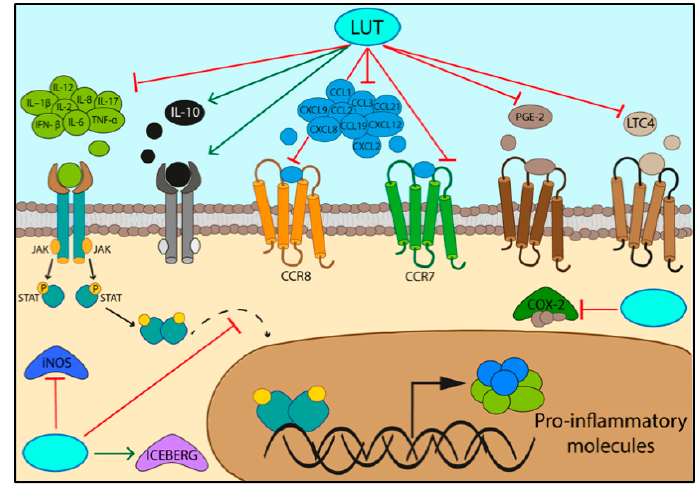
Figure 4. Luteolin and LUT-7G anti-inflammatory properties. Investigating the role of the two molecules in inflammation, a role for the LUT-7G in reducing inflammation by increasing the level of anti-inflammatory cytokine IL-10 and its receptor, IL10-RB [9,63], also emerged. Moreover, LUT-7G treatment enhances ICEBERG level (caspase-1 inhibitor) by blocking the secretion of IL − 1 β [64] (Figure 5), as well as inhibiting the NLRP3 inflammasome activation, which is responsible for IL − 1 β production [65,66] (Figure